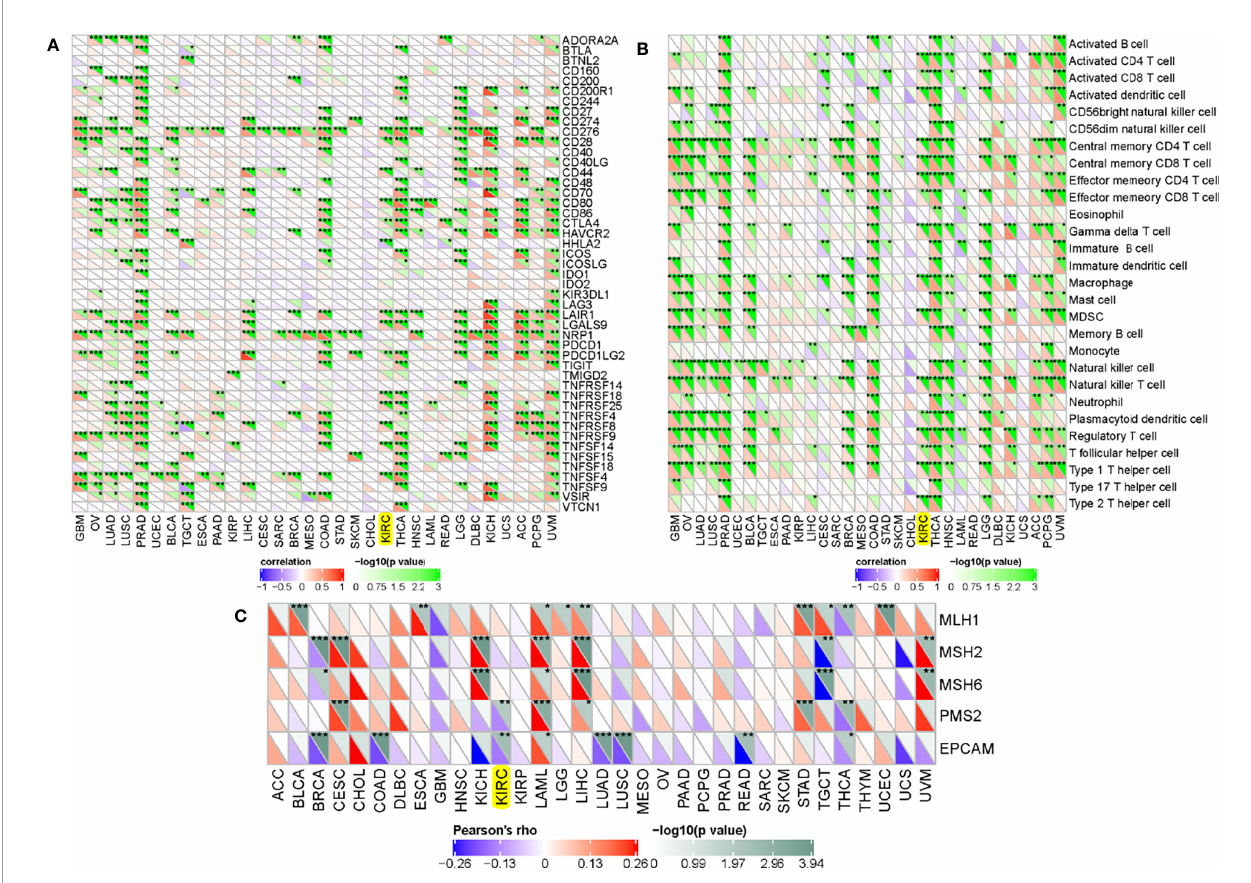
FIGURE 8 | Associations between ADAMTS14 and (A) immune checkpoint molecules, (B) immune cells, and (C) mismatch repair proteins in TCGA dataset. * p < 0.05; ** p < 0.01; *** p <